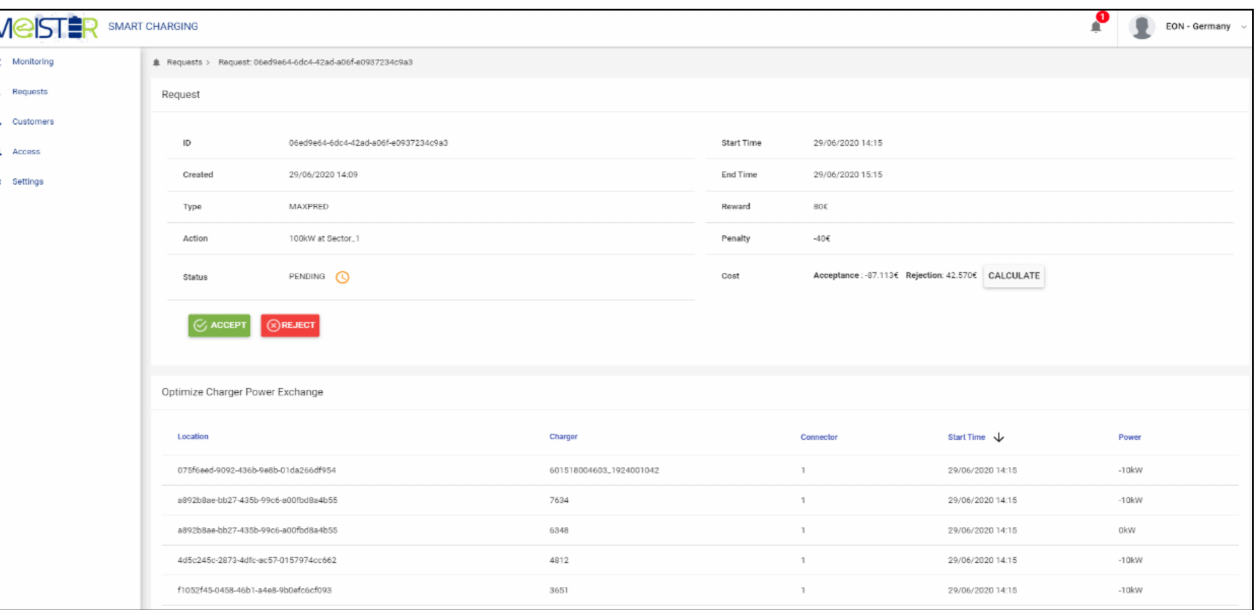
Figure 12. UC high load reduction “MAXPRED”, EV chargers setpoints (optimization algorithm).